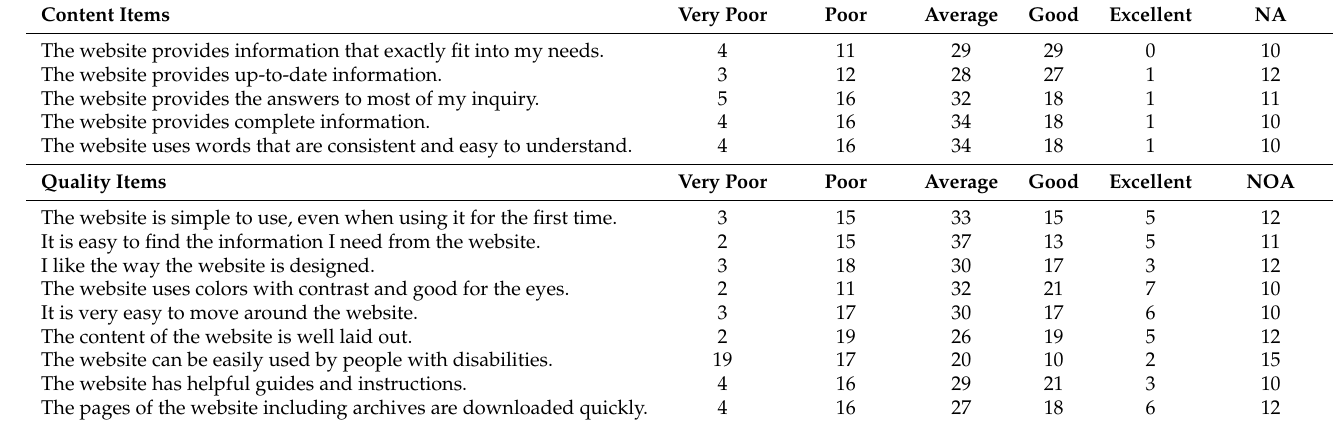
Table 4. Perceptions of government website content and quality by older